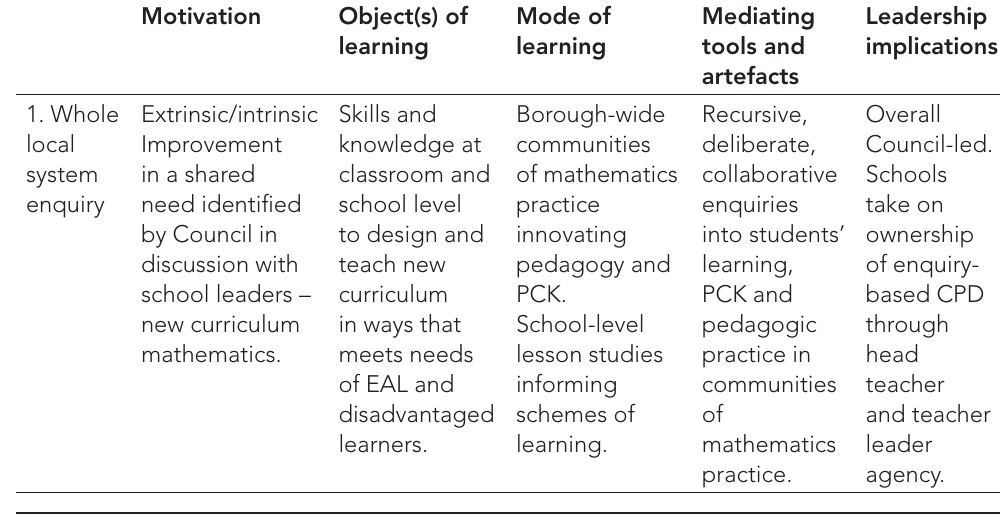
Table 1: Sociocultural classroom-, school- and system-level professional learning model – Stage